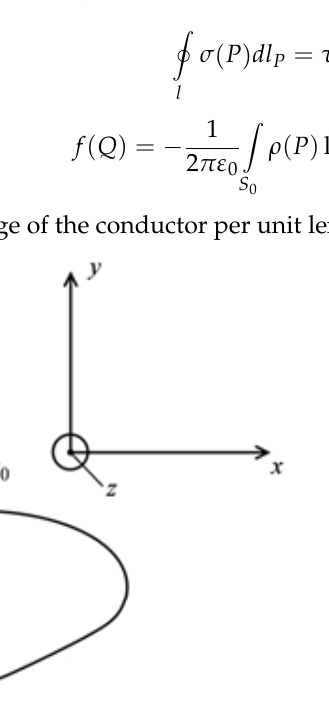
Figure 5. Electrostatic field, plane-parallel case, assuming an extended system along the z-axis.